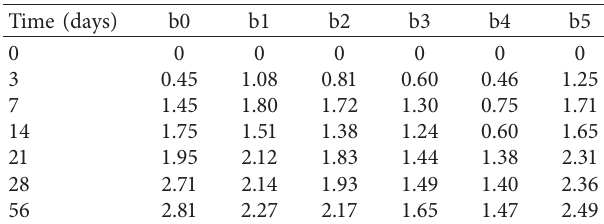
Figure 2: Graphical correlations between shrinkage value and moisture content. Table 5: Shrinkage values (mm/m) of the FC specimens with different contents of EP after different curing